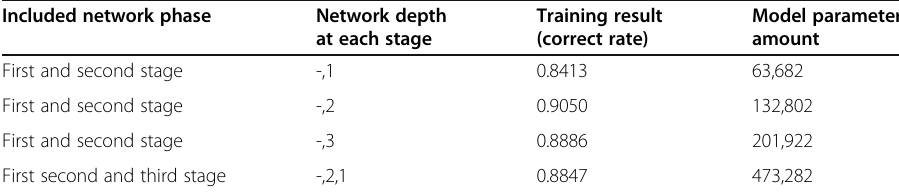
Training result (correct rate)